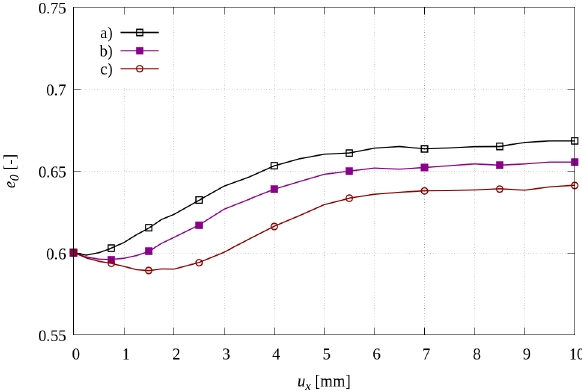
versus horizontal displacement u 0 = 200 kPa and c) σ 0